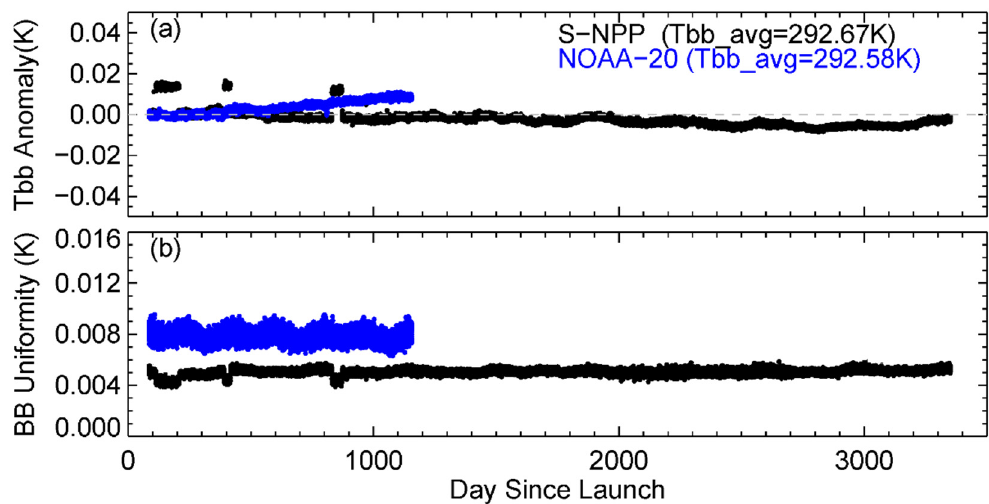
Figure 3. Time series of granual averaged on-board calibrator blackbody (OBCBB) temperature anomalies ( a ) ( T bb − T bb _avg) and uniformity ( b ) during nominal operations since the beginning of the NOAA-20 and S-NPP missions. Two nighttime granules from each orbit, used for VIIRS reflective solar bands (RSB) solar calibration, were used for long-term trending.